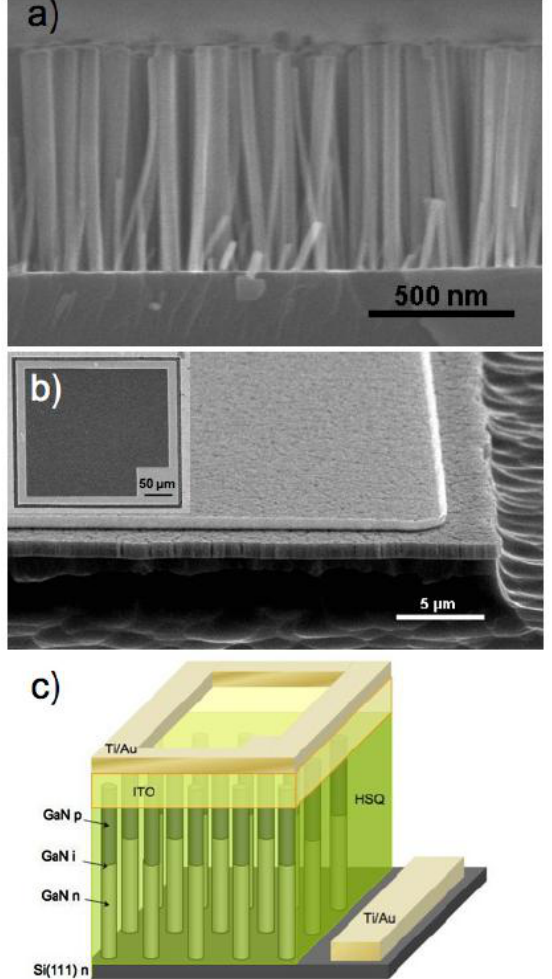
Figure 16. ( a ) Cross-sectional SEM image of as-grown nanowires; ( b ) 45°-tilted SEM image of a mesa photodetector; ( c ) Schematic representation of a mesa photodetector (reprinted from Reference